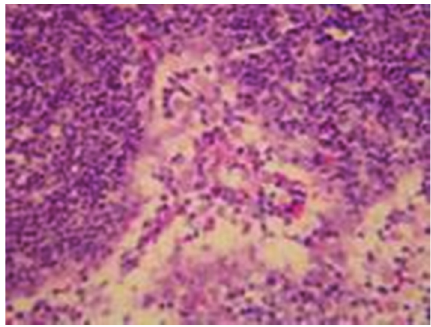
Figure 4: Model control group: 28 days in OJ rat hyperplasia of sinus cells, infiltration of a little eosinophile granulocytes, and a little hemorrhage, HE ×